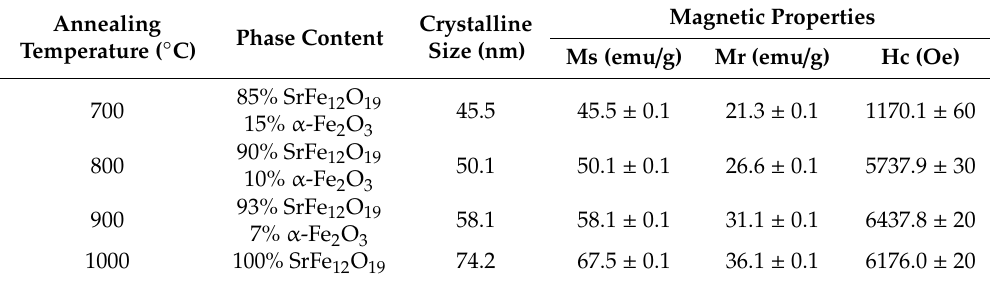
XRD patterns of SrFe 12 O 19 with an Fe / Sr molar ratio of 11.6 by varying the annealing temperature. Table 3. E ff ect of annealing temperature on the phase content, crystalline size, and magnetic properties of SrFe 12 O 19 samples obtained with an Fe / Sr molar ratio of 11.6.